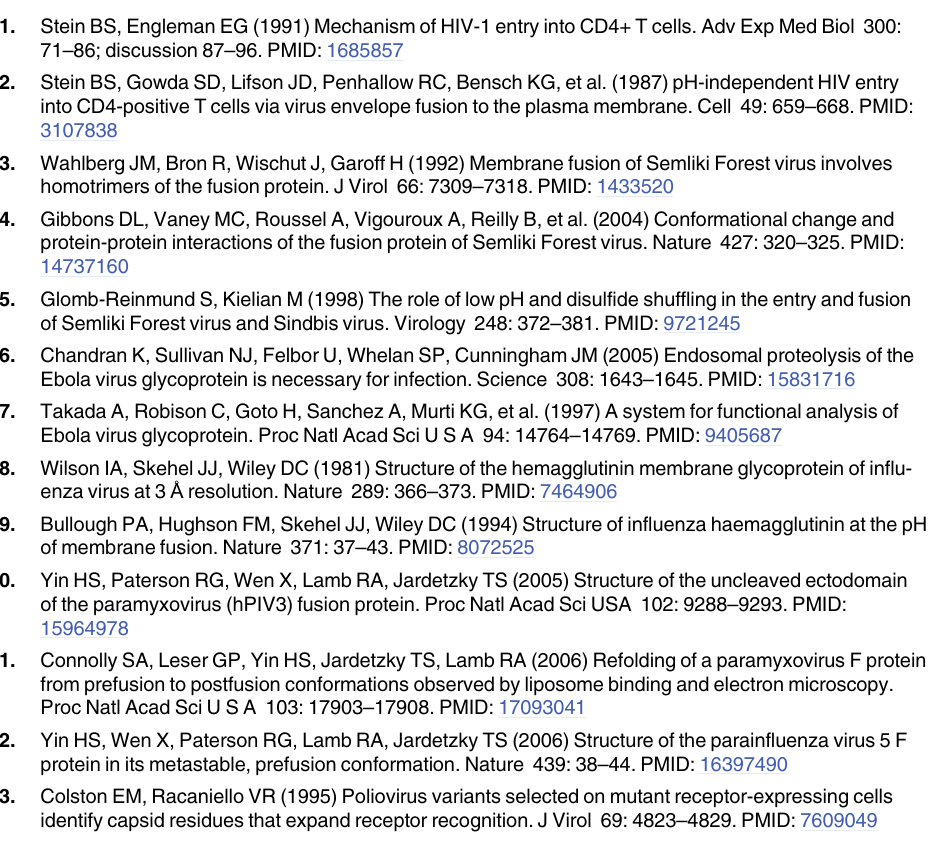
S8 Fig. Fecal titers are equivalent following inoculation with wild-type and σ 3-Y354H- con- taining reassortants. Newborn C57BL/6J mice inoculated perorally with 10 4 PFU of either stool samples were quantified by plaque assay. Results are expressed as viral titers for 3 – 4 mice per time point per virus. Differences in viral titer are not statistically significant by Student ’ s t test.